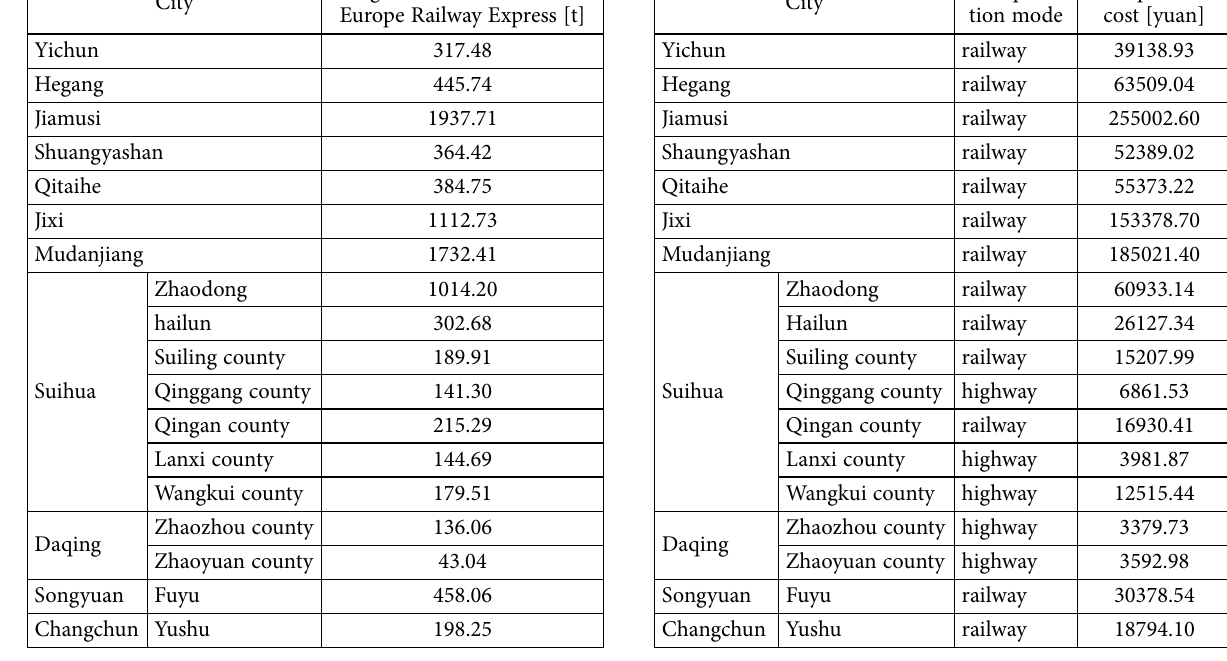
Table 6. Transportation modes and costs of railway container Table 4. The volume of freight transported to Harbin container terminal of every city in attraction area center station on Harbin – Europe Railway Express in 2020 Freight volume on Harbin – City Europe Railway Express [t]